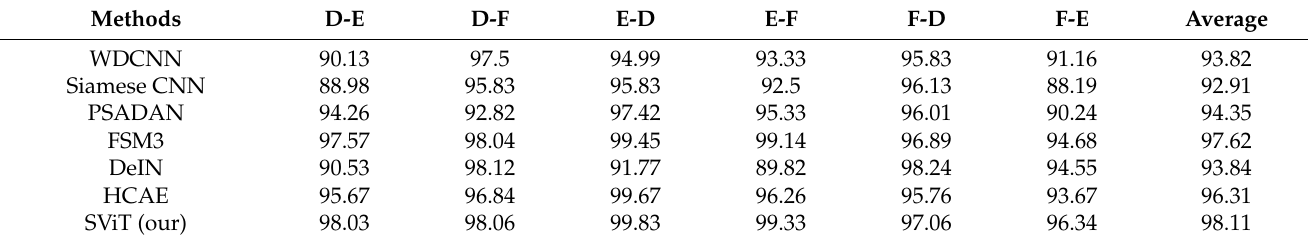
Table 15. Mean classification accuracy (%) with 1800 samples on the Paderborn dataset.